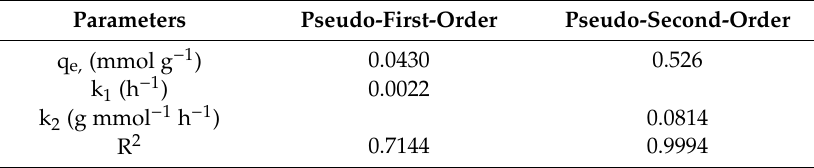
Table 2. Parameters for adsorption kinetics.